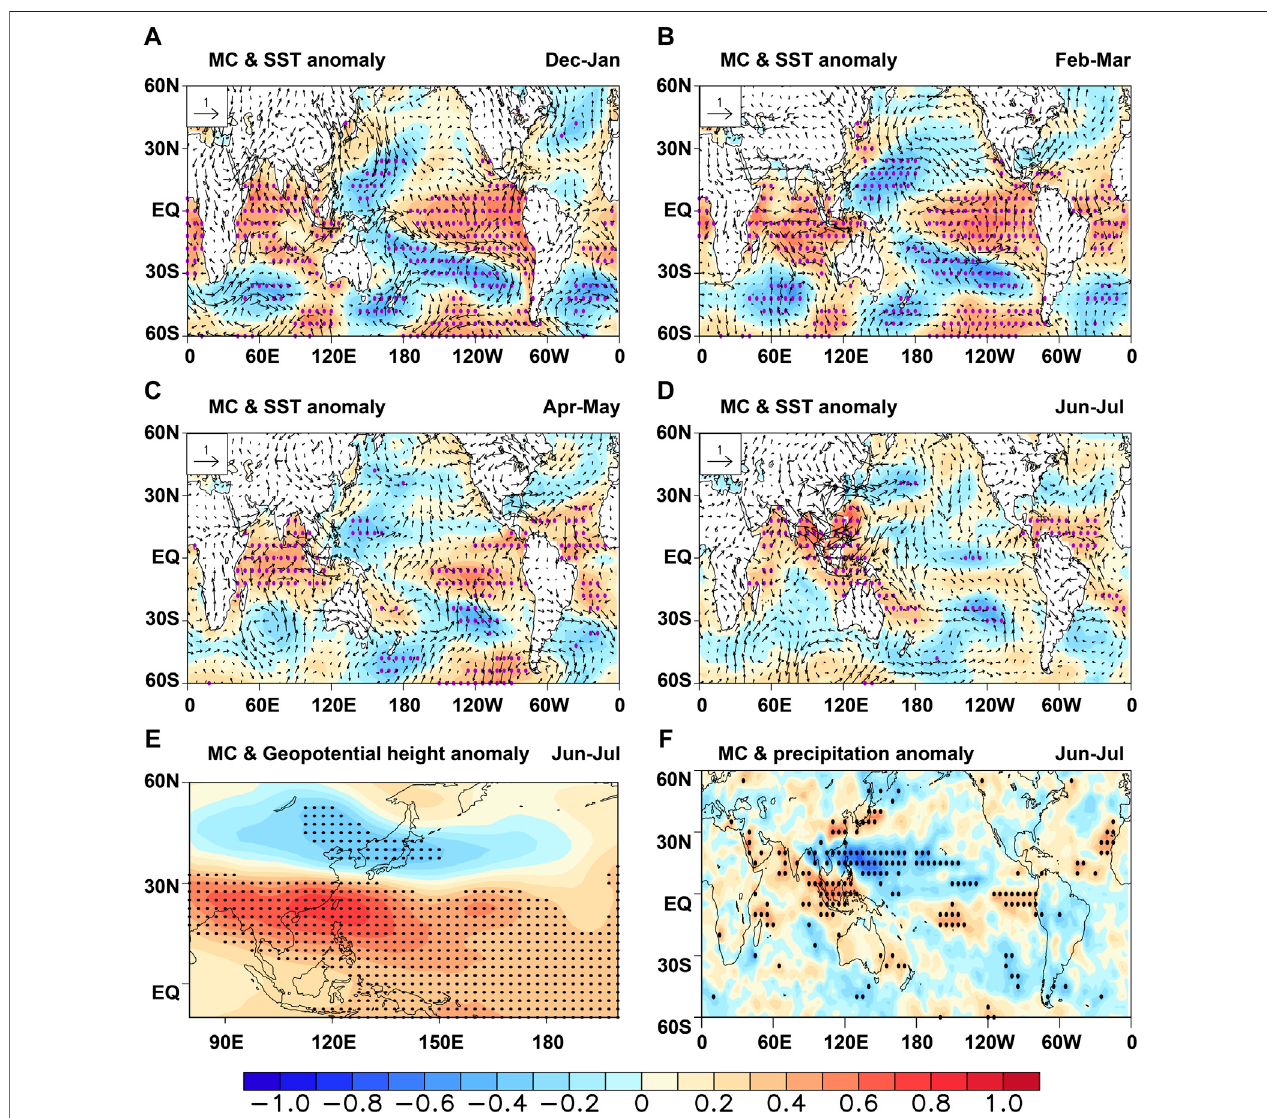
FIGURE 4 | Correlation between the regionally averaged vertical velocity anomaly of the MC over the region of the western part of the WPSH (110 ° E – 140 ° E, 15 ° N – 25 ° N) in June – July derived from the ensemble means of fi ve reanalysis data sets and the sea surface temperature (SST) anomaly (shading) and horizontal wind anomaly (vector) in (A) December – January, (B) February – March, (C) April – May, and (D) June – July from 1979 to 2020 based on the seasonal means. (E) Same as (D) but for the correlation between the regionally averaged vertical velocity anomaly of the MC and the geopotential height anomaly at 500 hPa in June – July. (F) Same as (D) but for the correlation between the regionally averaged vertical velocity anomaly of the MC and the precipitation anomaly in June – July. Stippling over the shading indicates that these correlation coef fi cients are signi fi cant above the 95% con fi dence level based on Student ’ s t -test.